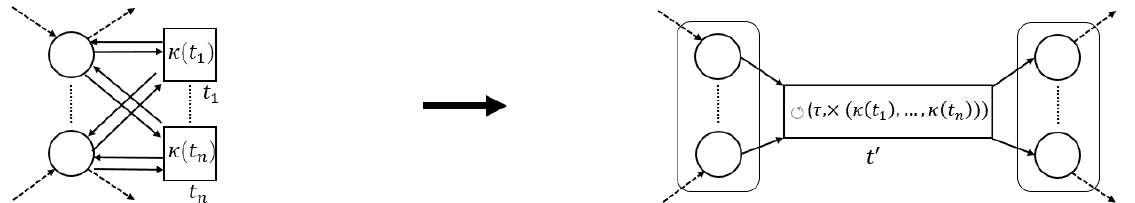
Figure 15. Schematic visualization of the (cid:9) s -pattern reduction. The pre- and post-set of transitions t 1 , t 2 ,..., t n are the same. In the reduction, the places are “split” into two groups, one copying all dashed incoming arcs, one copying all dashed outgoing arcs. The newly added transition t (cid:48) is placed in between with label (cid:9) ( τ , × ( κ ( t 1 ) ,..., κ ( t n )))